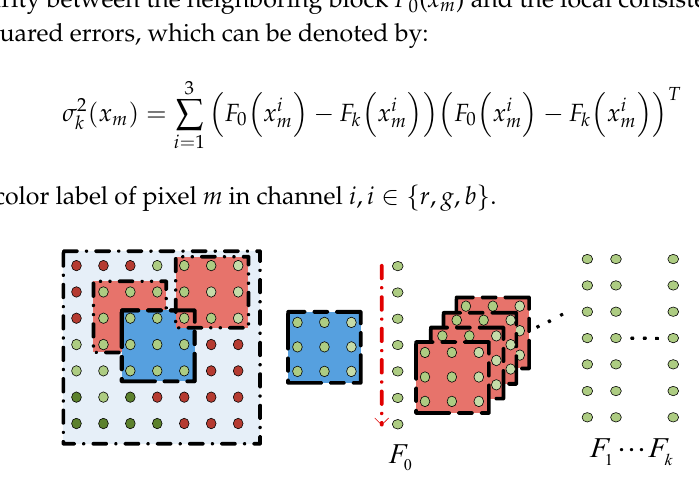
Figure 3. Vector representation of clique pixels.